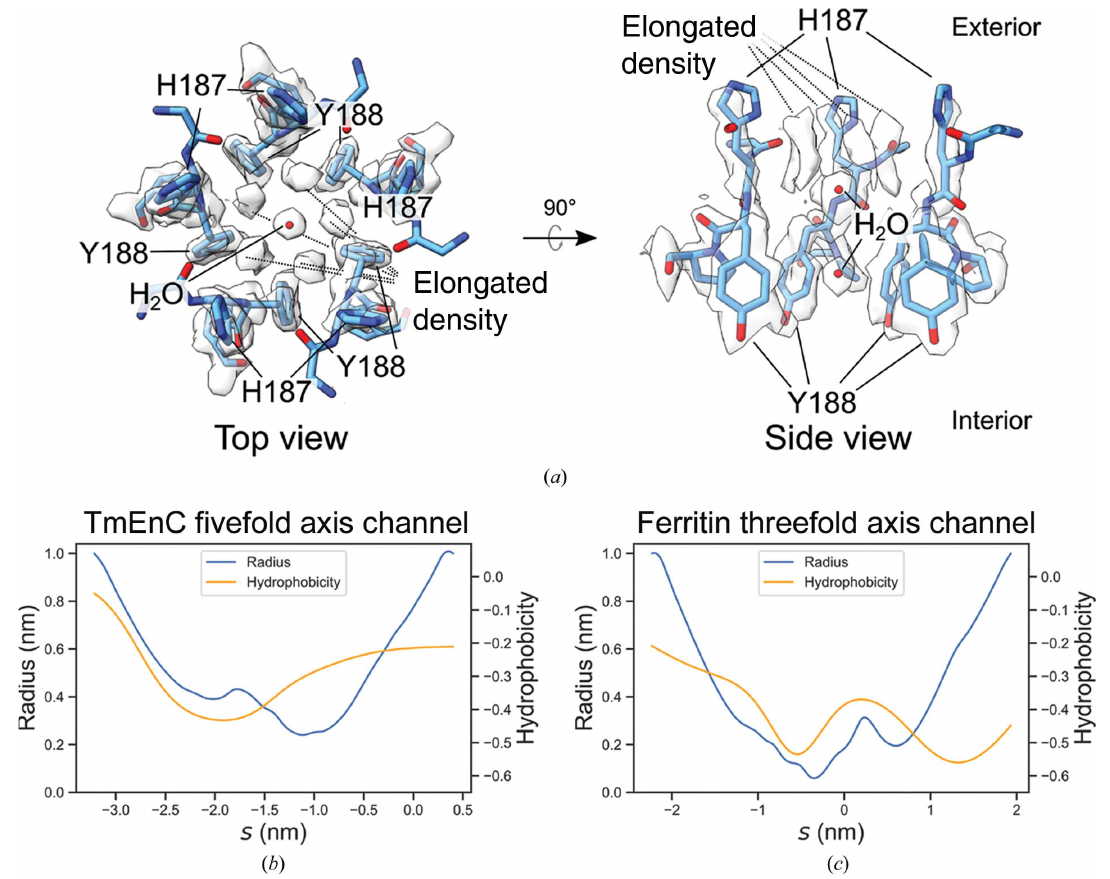
Figure 2 Putative iron-transport channels. ( a ) The fivefold axis channel consists of His187 and Tyr188. The left image shows the top view looking at the channel from the exterior into the interior of TmEnc and the right image is a cut-through side view. Density corresponding to two solvent molecules or ions is present in the channel. Above the two molecules are fivefold-symmetric elongated densities that could not be identified confidently. ( b , c ) Radius and hydrophobicity plots using data from CHAP of ( b ) the TmEnc fivefold axis channel and ( c ) the ferritin threefold axis channel as a function of probe position s . More negative s values correspond to positions closer to the exterior and vice versa. Hydrophobicity is measured with the Wimley–White scale (Wimley & White, 1996). Scales for each graph are identical for